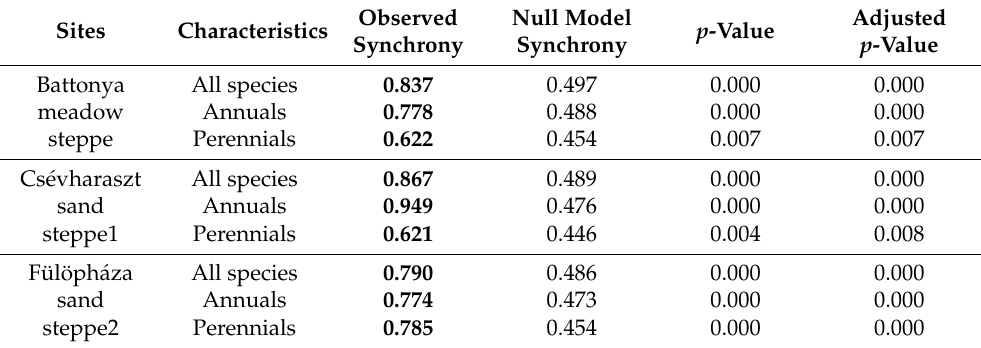
Table 3. Local synchrony of species richness time series recorded at different scales. Corrected p -values were adjusted for multiple tests by the Bonferroni–Holm method. Bold numbers indicate significant associations.